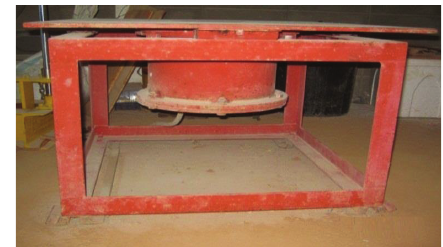
Table 5: Conversion for peak value in sinusoidal motion,